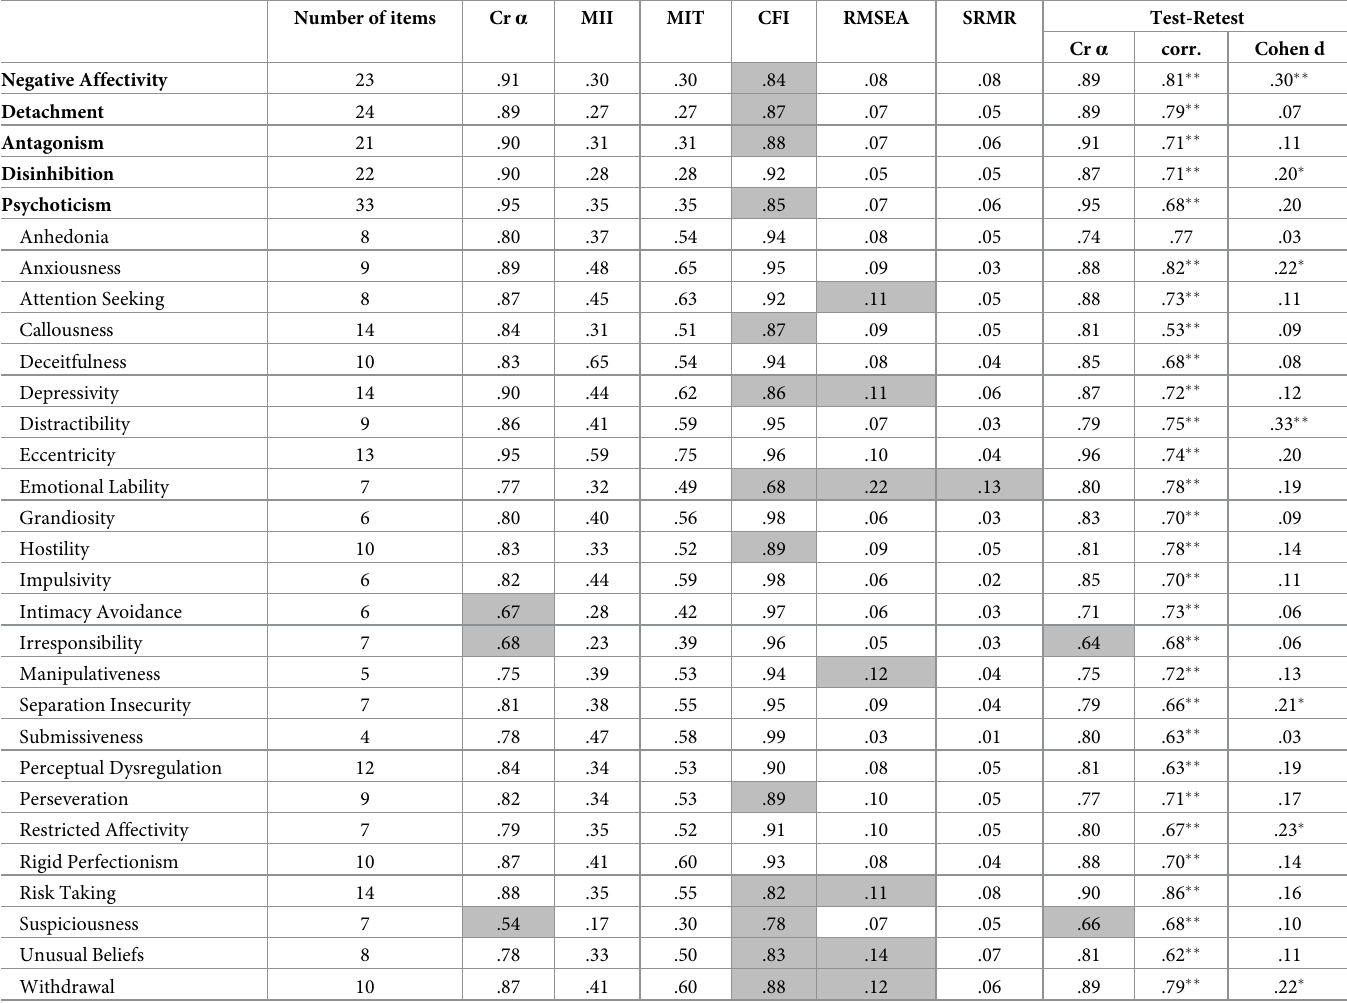
Table 4. Internal consistency and item level CFA of Personality Inventory for DSM-5 facets and